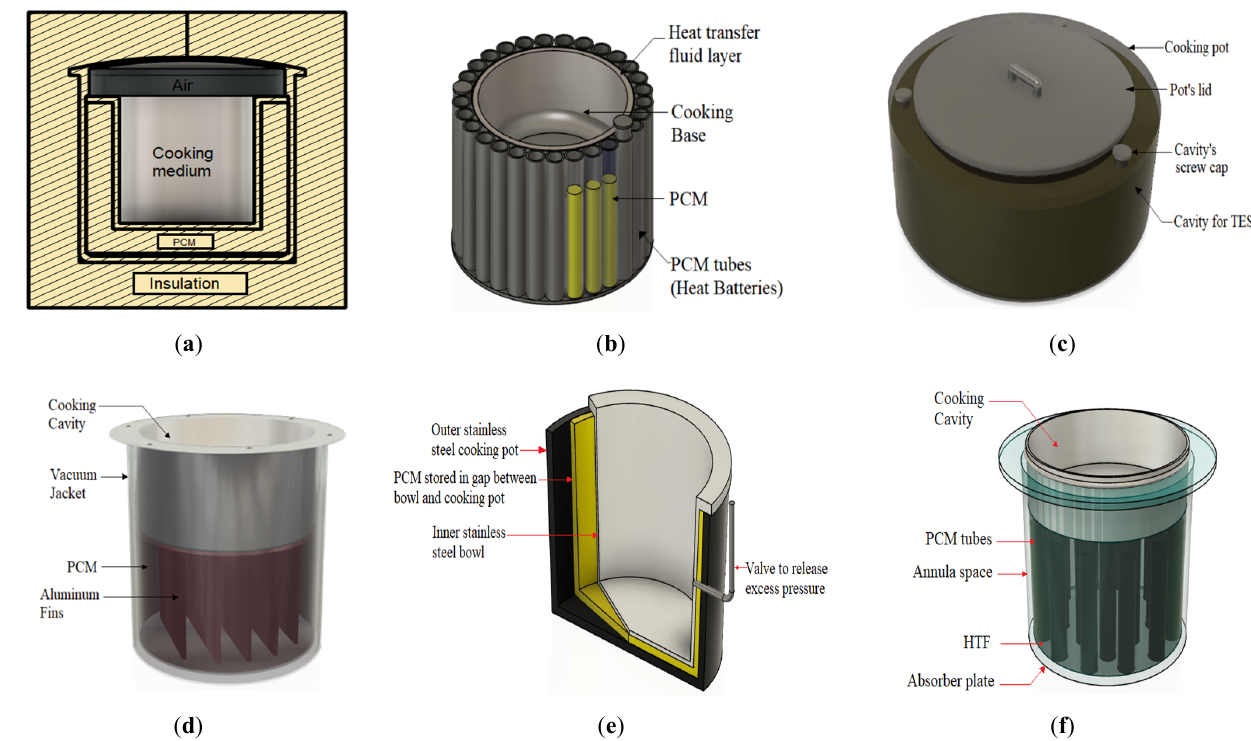
Figure 9. Development of portable solar cookers ( a ) Boundary elements of portable heat storage cooking utensils Lecuona et al., (2013) [120]. ( b ) solar cooker with heat batteries Rekha et al., (2021) [87]. ( c ) Solar storage cooking pot Mawire et al., (2022) [88]. ( d ) solar receiver cum thermal storage with the finned cooking vessel [121]. ( e ) Components of PCM-integrated cooking pot Keith et al., (2019) [86]. ( f ) Storage-cooking utensils and PCM tubes Bhave and Thakare (2018) [122]. Reprinted/adapted with permission.